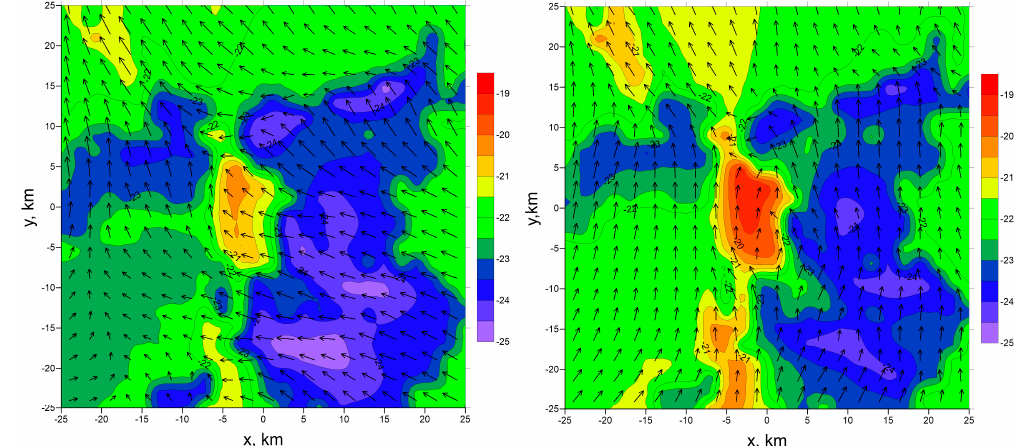
Figure 5. The urban heat island (in the center of the domain) calculated by TSUNM3 on 1 February 2018 (left) and 19 November 2018 (right), 4 a.m. local time. The contour maps indicate 2 m temperature (in °C) and the vector field is 10 m wind speed. The distribution of land use categories is shown in Figure 1. The extent of the computational domain is given in km.